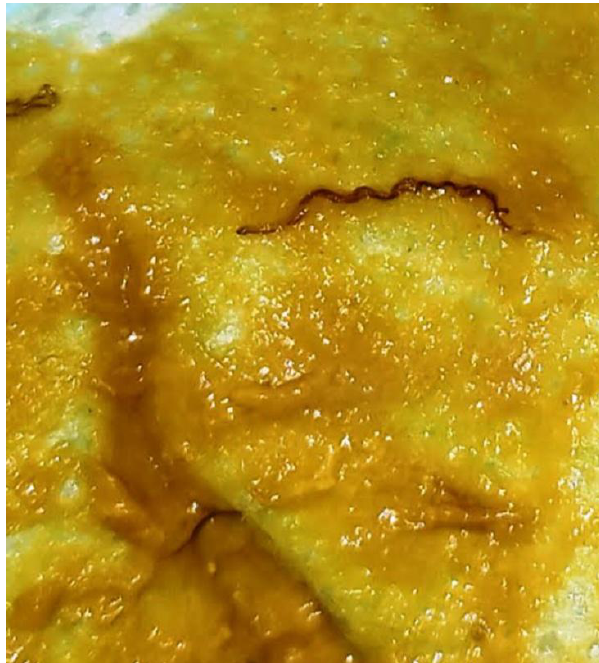
Figure 1: The thread-like pattern observed in the infant stool, day-1